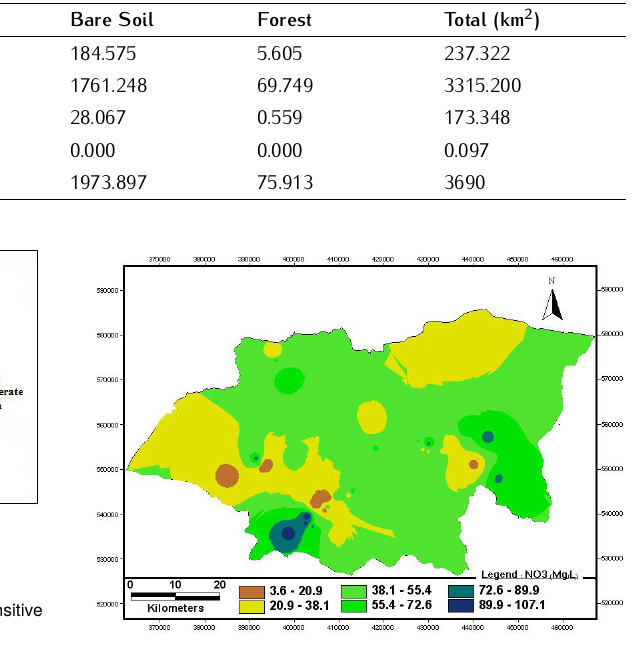
Figure 15. NO − 3 concentrations in groundwater samples from the study